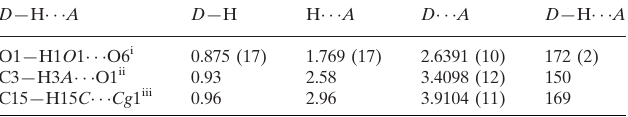
Data collection Bruker SMART APEX Duo CCD area-detector diffractometer Absorption correction: multi-scan ( SADABS ; Bruker, 2009) T min = 0.950, T max = 0.972